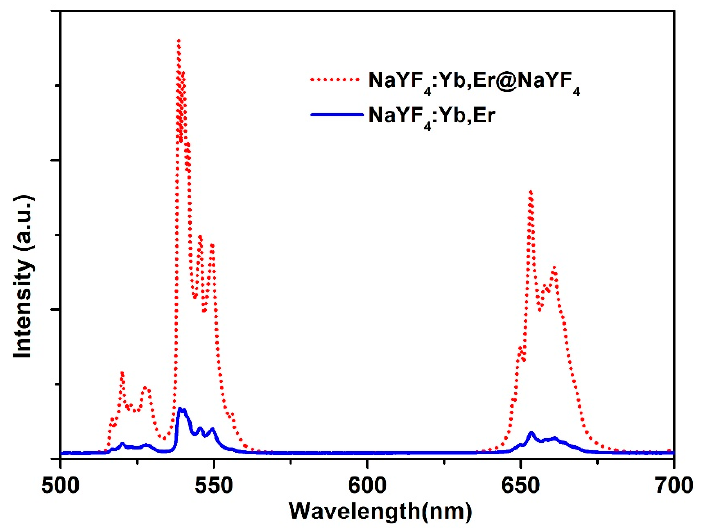
Figure 4. The UC emission spectrum of NaYF 4 :20%Yb 3+ ,2%Er 3+ and NaYF 4 :20%Yb 3+ ,2%Er 3+ @NaYF 4 nanocrystals. Excitation wavelength is 980 nm.